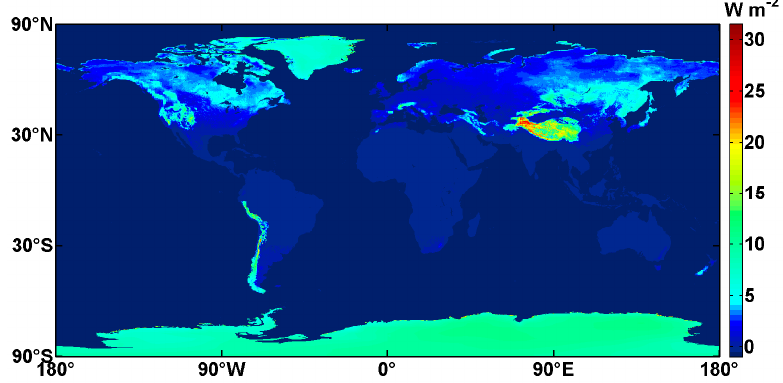
Figure 4. Spatial distribution of annual mean snow albedo radiative forcing during 2003–2016.